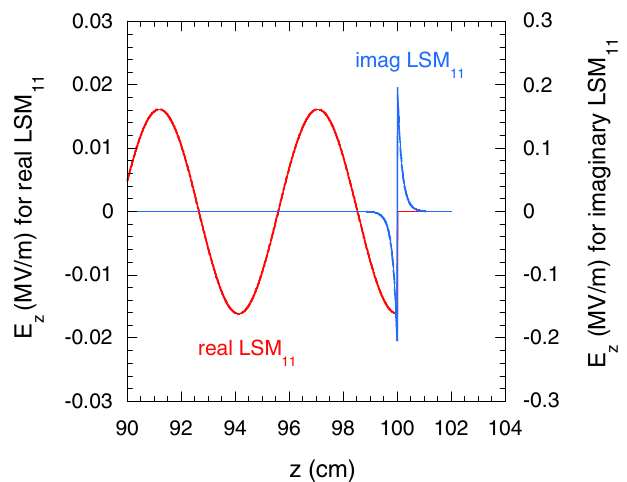
on axial z (cid:4) r 2